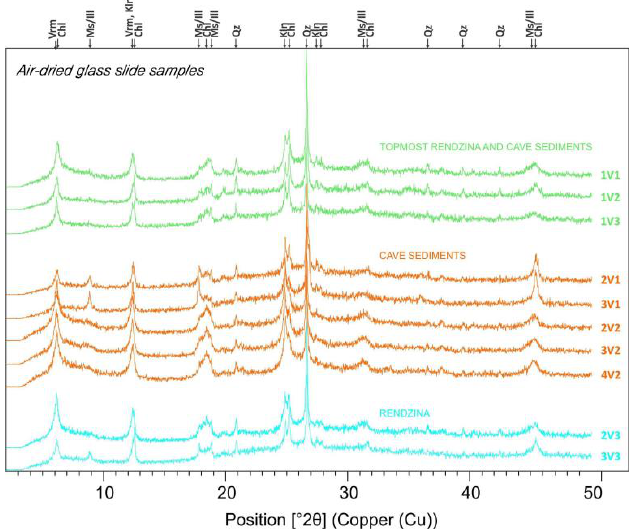
Figure 15. X-ray diffraction (XRD) patterns of air-dried oriented samples with the determined minerals (Vrm-vermiculite, Chl-chlorite group minerals, Ms/Ill-muscovite/illite, Kln-kaolinite, Qz-quartz).